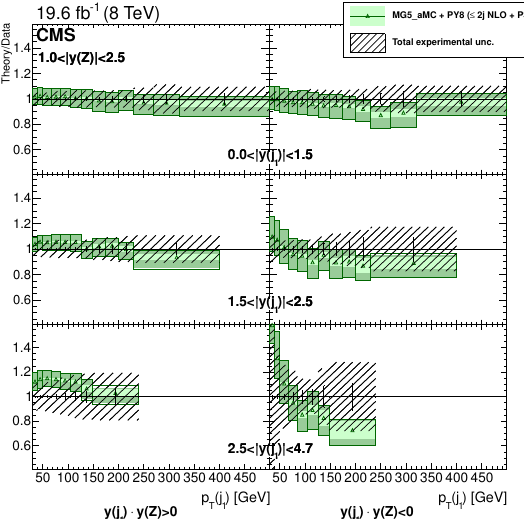
Figure 43 . Ratio to the measurement of the di(cid:11)erential cross section d 3 (cid:27)= d p T (j )d y (j )d y (Z) 1 1 obtained with mg5 a mc + pythia 8, with up to two jets at NLO, for j y (Z) j 2 (1 ; 2 : 5). Left column corresponds to y (j ) y (Z) > 0 and right column to y (j ) y (Z) < 0. The total experimental uncertainty 1 1 is shown as a band around 1. Uncertainties in the predictions are shown on the ratio points and include the statistical, theoretical, and PDF uncertainties. The dark green area represents the statistical and theoretical uncertainties only, while the light green area represents the statistical uncertainty alone.